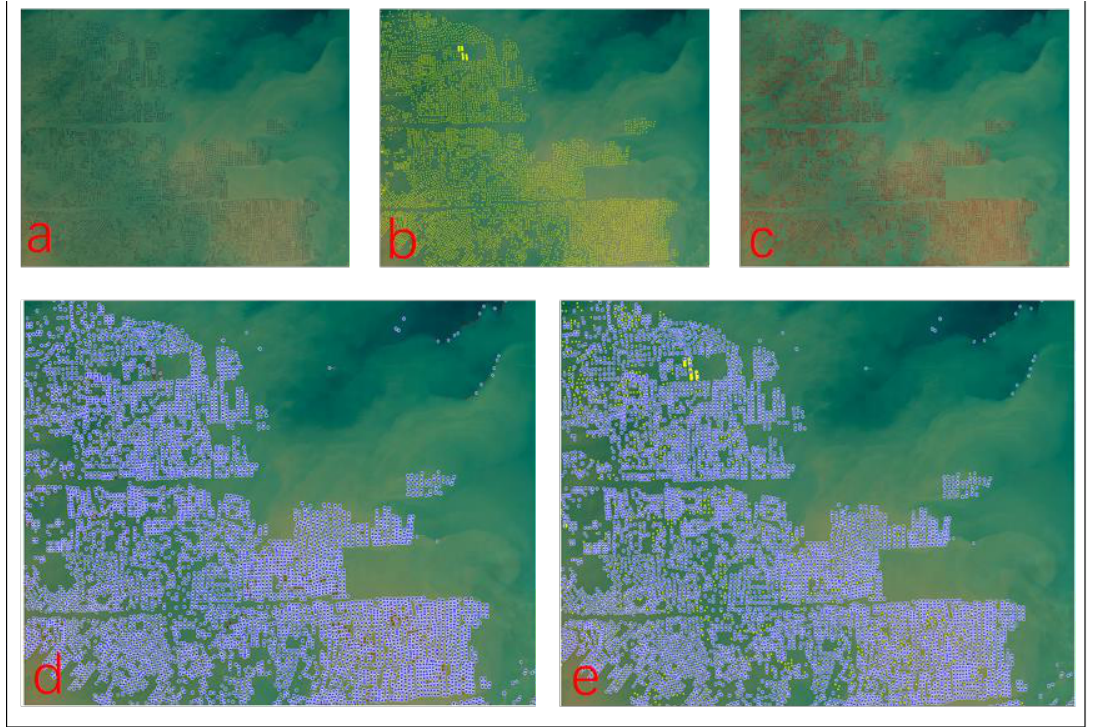
Figure 6. Experimental results in study area 1: ( a ) original image; ( b ) visual interpretation results; ( c ) identification results; ( d ) quantitative identification results; ( e ) overlap between the quantitative identification results and the visual interpretation results.